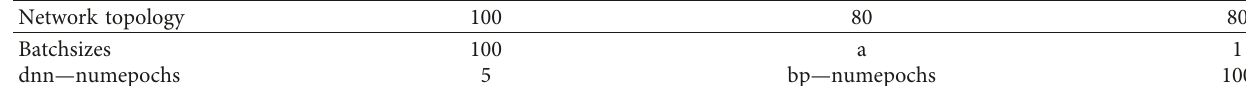
Figure 1: Comparison of the neural network identification rates across each layer. Table 1: Deep neural network parameter settings.